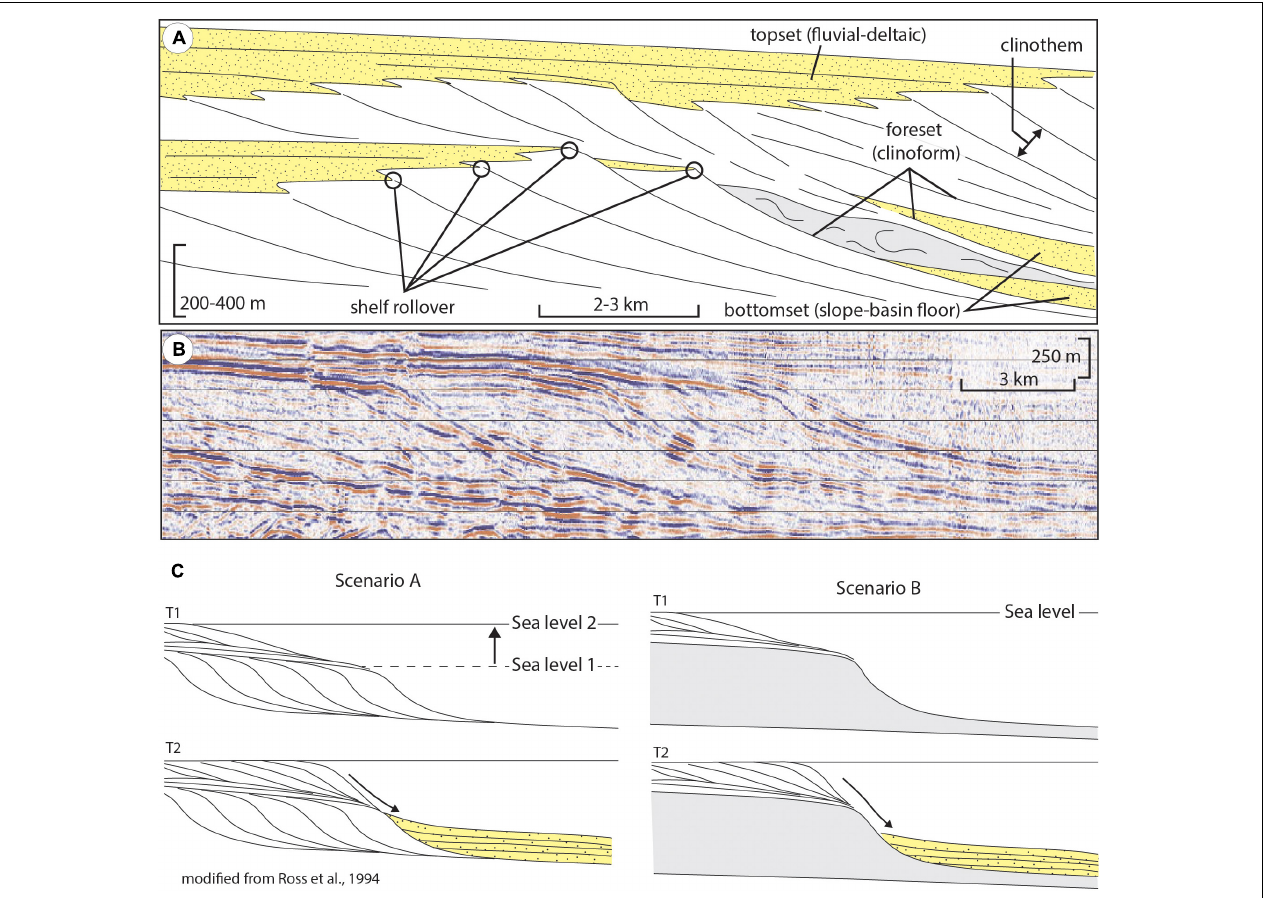
FIGURE 1 | (A) Schematic dip-oriented basin margin cross-section. Note the variety of clinoform scales indicated. (B) Seismic section from the Alaska North Slope showing clinoforms of moderate to high-relief; red = peak, black = trough, frequency ∼ 36 Hz (United States Geological Survey Data accessed from www.sepmstrata.org). (C) Two scenarios of slope oversteepening that result in shelf-margin readjustment and phases of enhanced coarse-grained sediment delivery beyond the shelf margin. Scenario (A) results from a significant relative sea-level rise; after a substantial transgression, the slope profile becomes oversteep and unstable once it progrades back to the point where it reaches the former, drowned shelf margin. Scenario (B) results from the progradation of a shelf-margin system to the edge of an escarpment. In this instance, the slope also steepens and becomes more unstable, leading to onlap of basin floor fan deposits onto the slope (modified from Ross et al.,